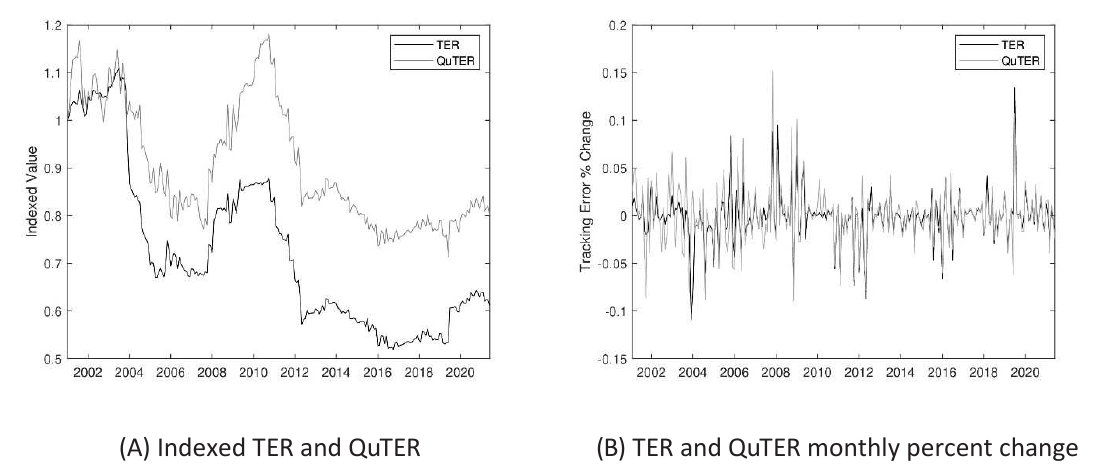
Figure 9. TER and QuTER (3-year rolling